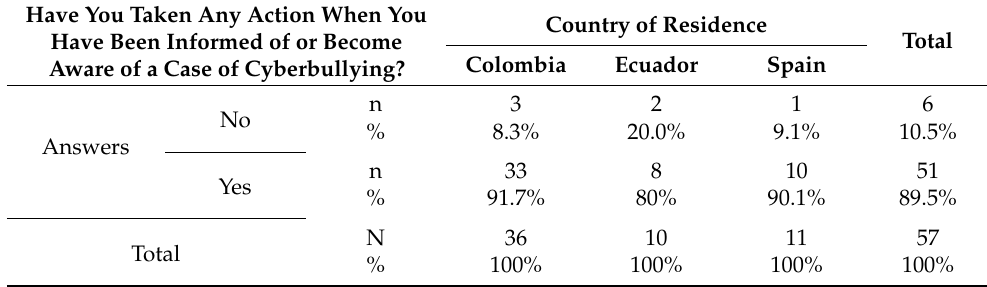
Table 11. Cross-categorization of the variable “Have you taken any action in case of cyberbullying?” and the variable “Country of residence”.